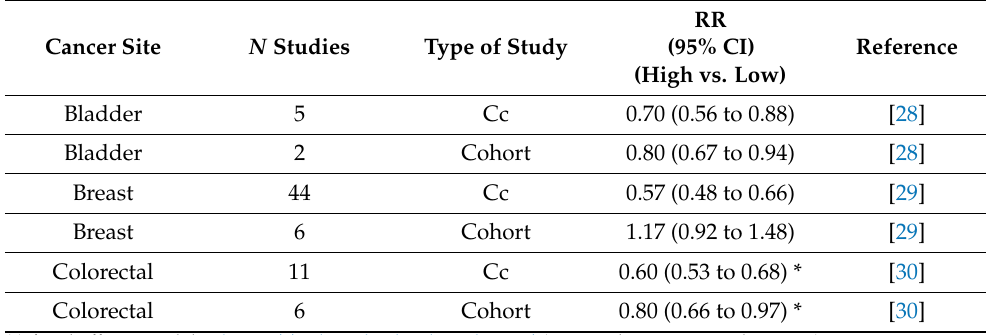
Table 2. Meta-analyses of observational studies of individual cancer site risks in relation to serum 25(OH)D concentrations